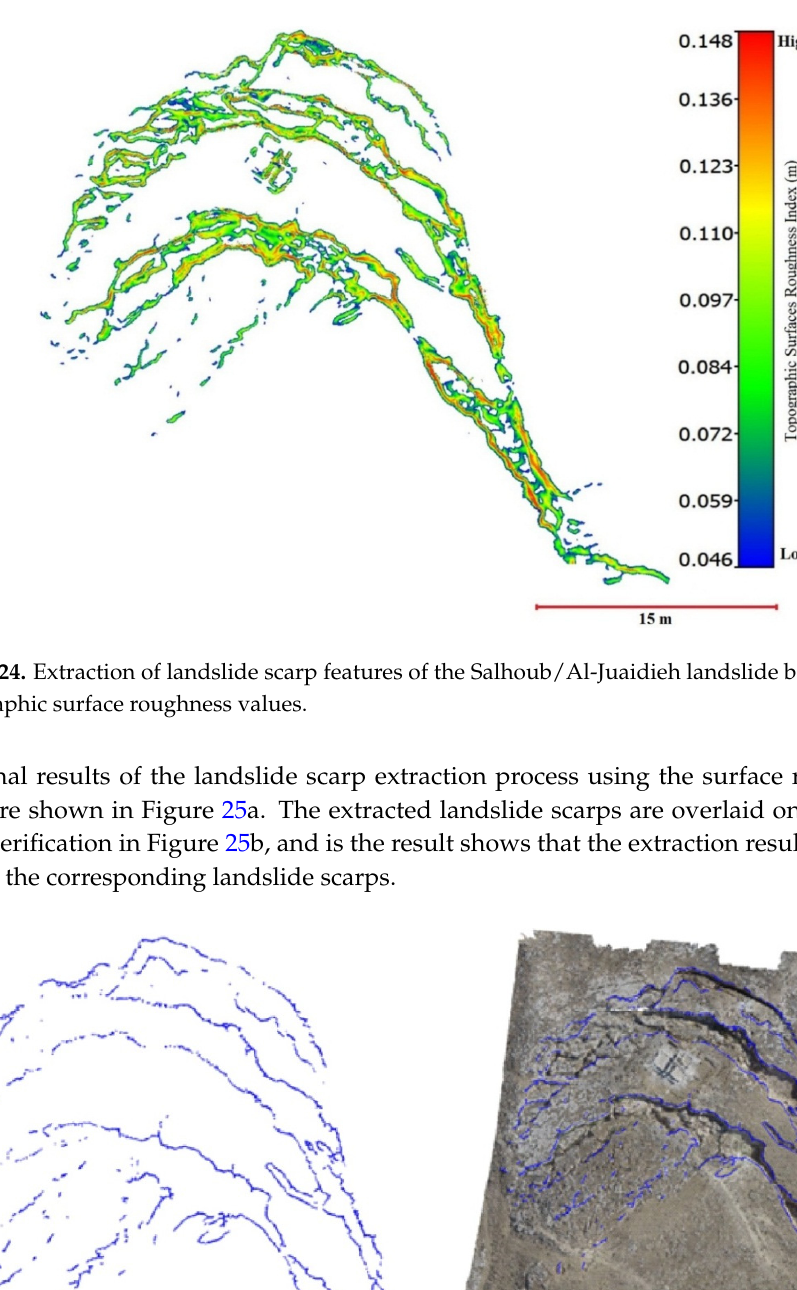
Figure 23. Statistics of the topographic surface roughness index distribution.